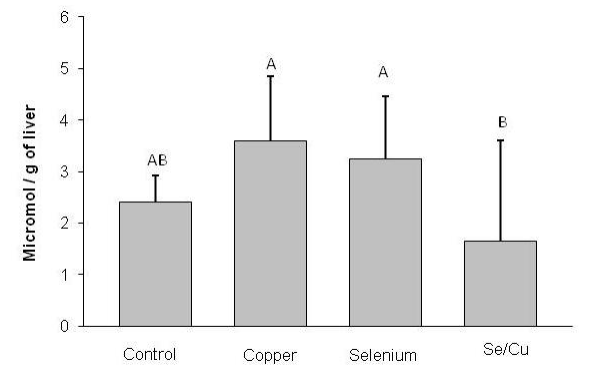
Figure 2. GSH and standard deviations, in  mol per gram of liver, of cattle receiving control diet (without supplementation of selenium and copper), copper (40 mg/kg of DM), selenium (2 mg/kg of DM), or selenium (2 mg/kg of DM)/copper (40 mg/kg of